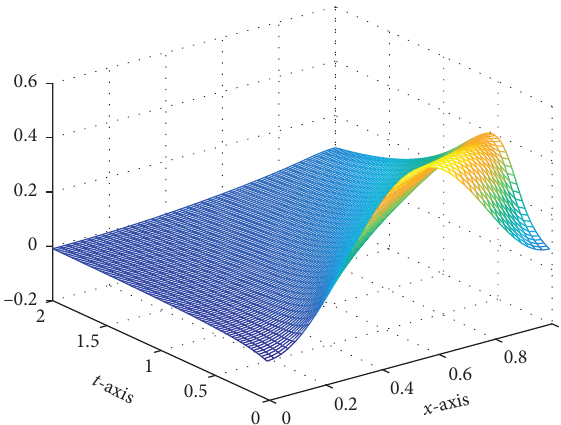
Figure 2: Graph of the exact solution of p ( x,t ) at t � 2 with h � 1/40.